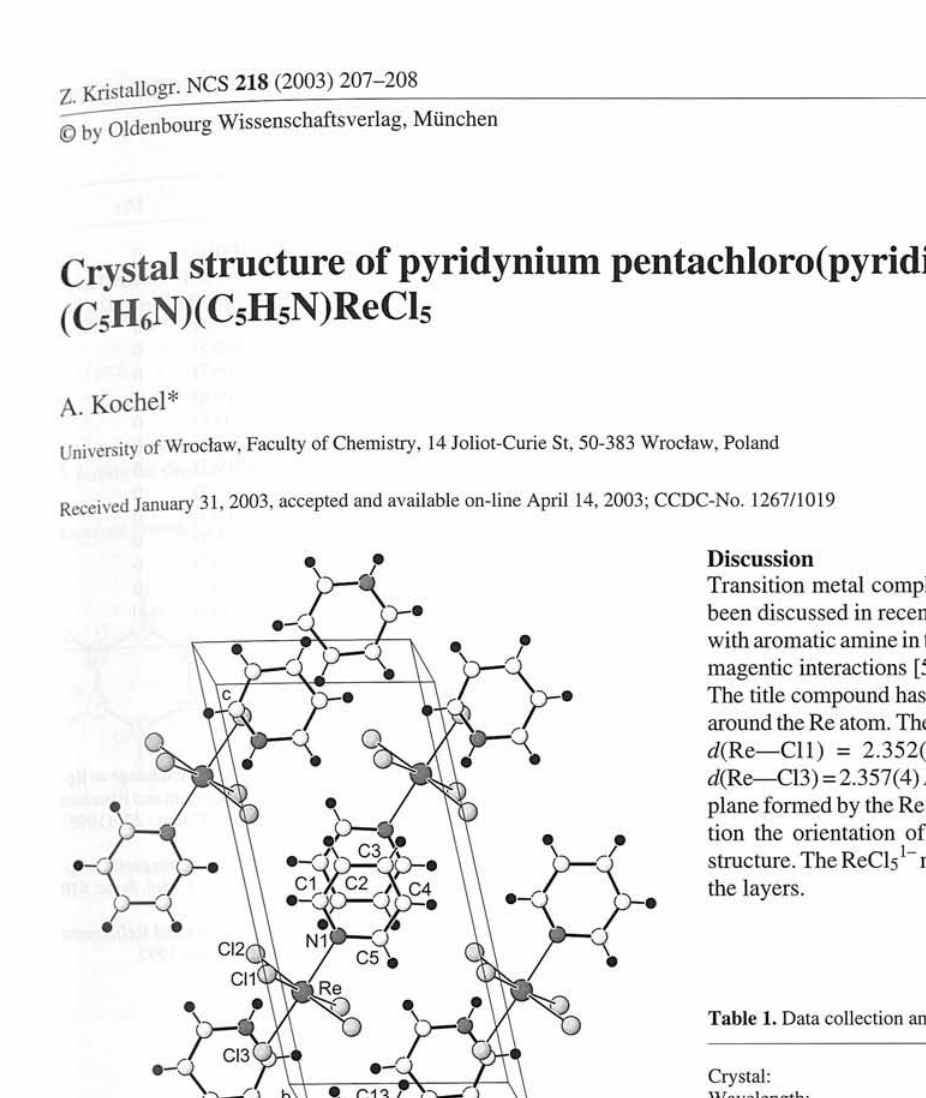
Table 1. Data collection and handling.